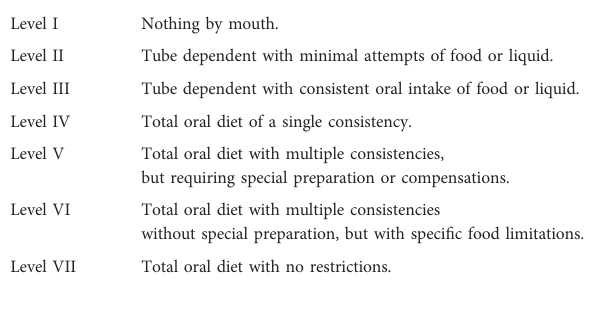
TABLE 2 Functional oral intake scale (FOIS) (11).